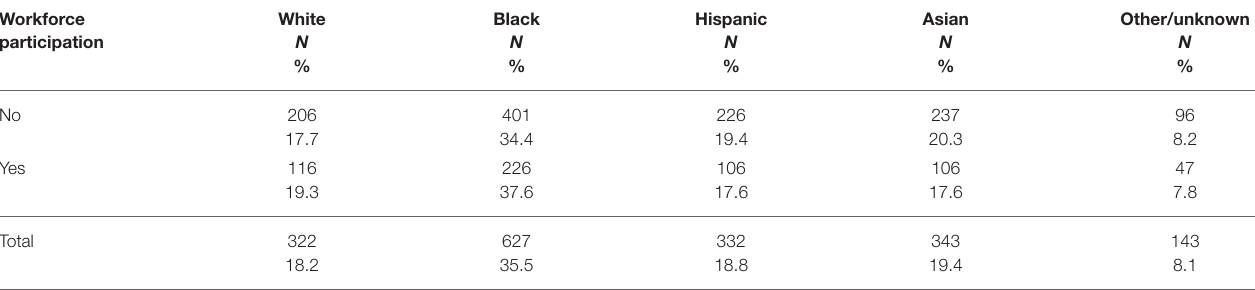
TABLE 2 | Workforce participation across race/ethnic background.